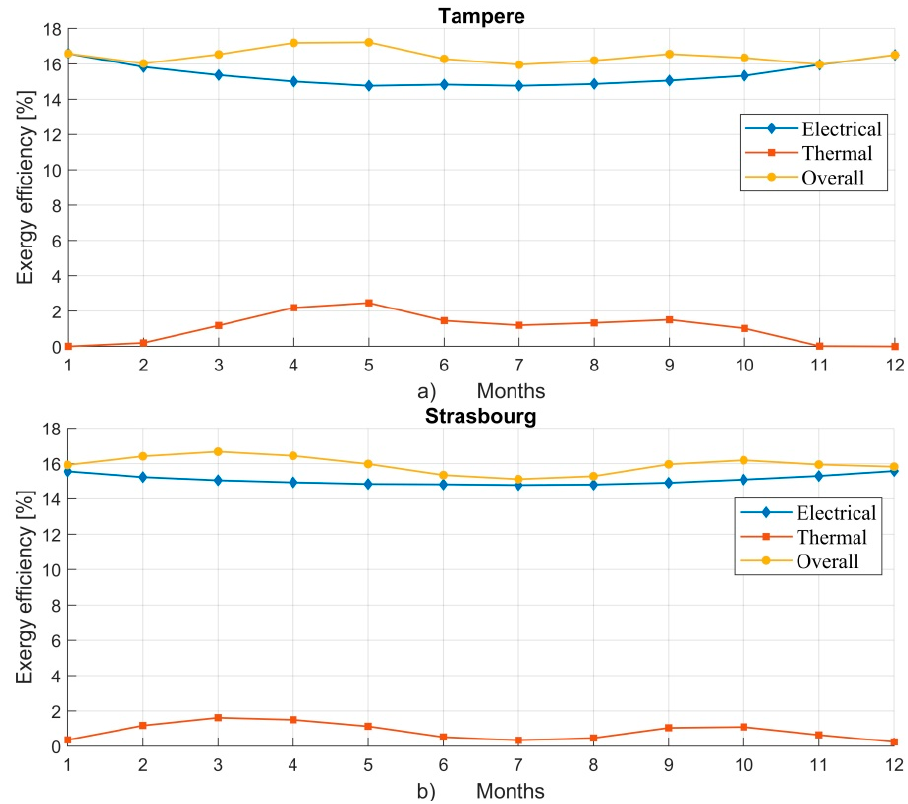
Figure 9. Thermal, electrical and overall monthly exergy efficiencies in ( a ) Tampere and ( b ) Strasbourg.